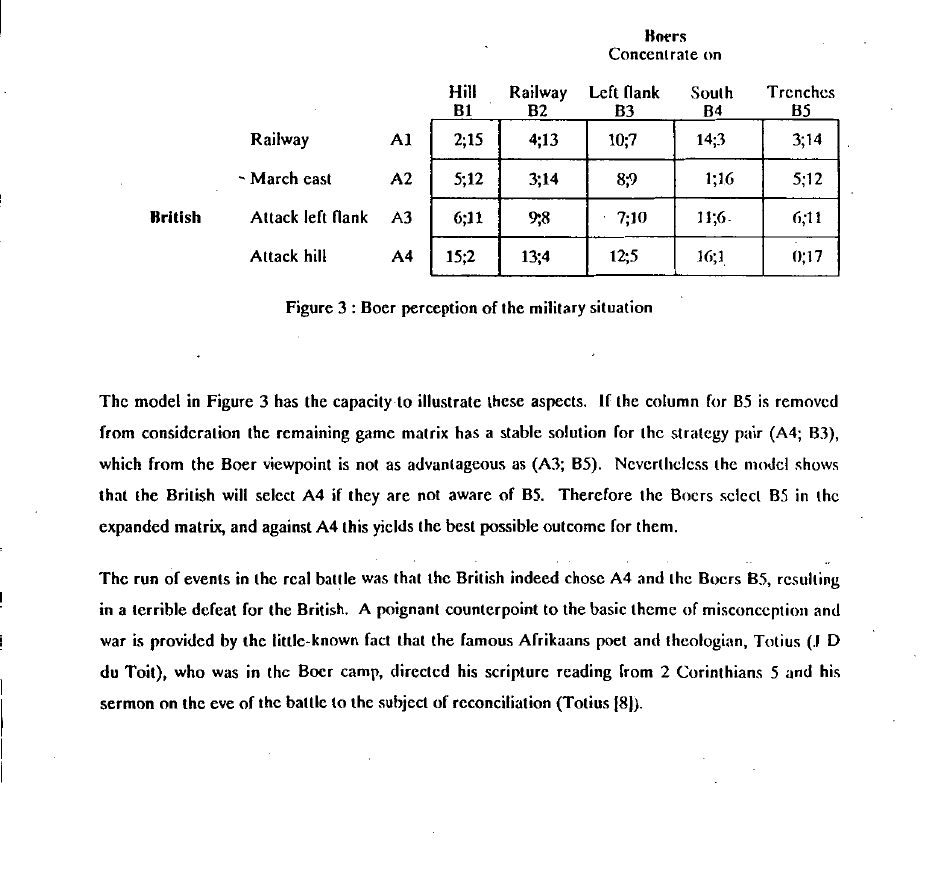
Figure 3 : Boer perception of the military